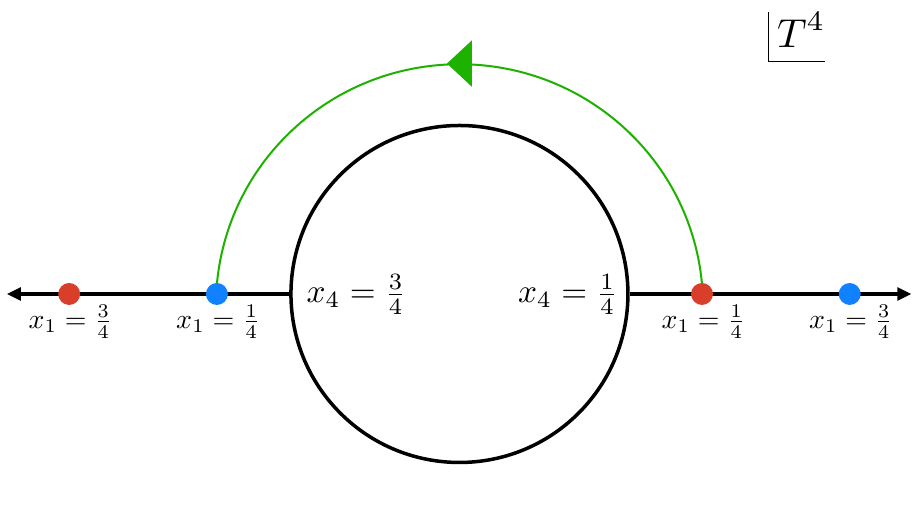
Figure 4 . The action of α -monodromy on a T 2 singular locus in the N = 2 example. Pictured is the T 4 within the covering T 7 that is defined by x = x = x = 0 . The x - and x -dimensions 2 5 6 3 7 are suppressed, so that each colored circle represents a T 2 . The fibers π − 1 (1 / 4) and π − 1 (3 / 4) 4 4 are pictured, represented by the x -direction only. The two T 2 ’s represented by red circles are 1 interchanged by the action of α , as are those represented by blue circles. By following the green contour from the x = 1 / 4 fiber to the x = 3 / 4 fiber and applying α , one ends up with a monodromy 4 4 action by α on the singular loci of the x = 1 / 4 4